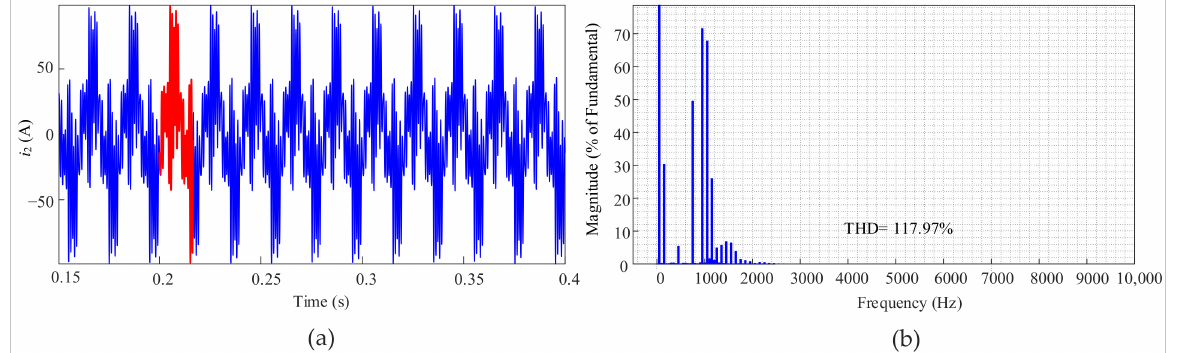
Figure 8. Simulation waveform of the grid-side current i L2 and its FFT analysis result in Simulation 2 when L g = 0 and with the 5th order resonance controller applied: ( a ) The simulation waveform; ( b ) the FFT analysis